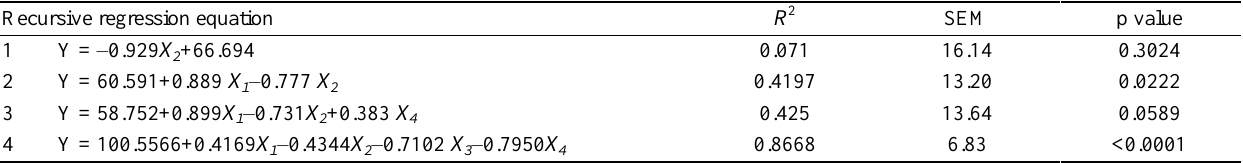
Table 4. The regression equation of predicted digestibility of RUP Recursive regression